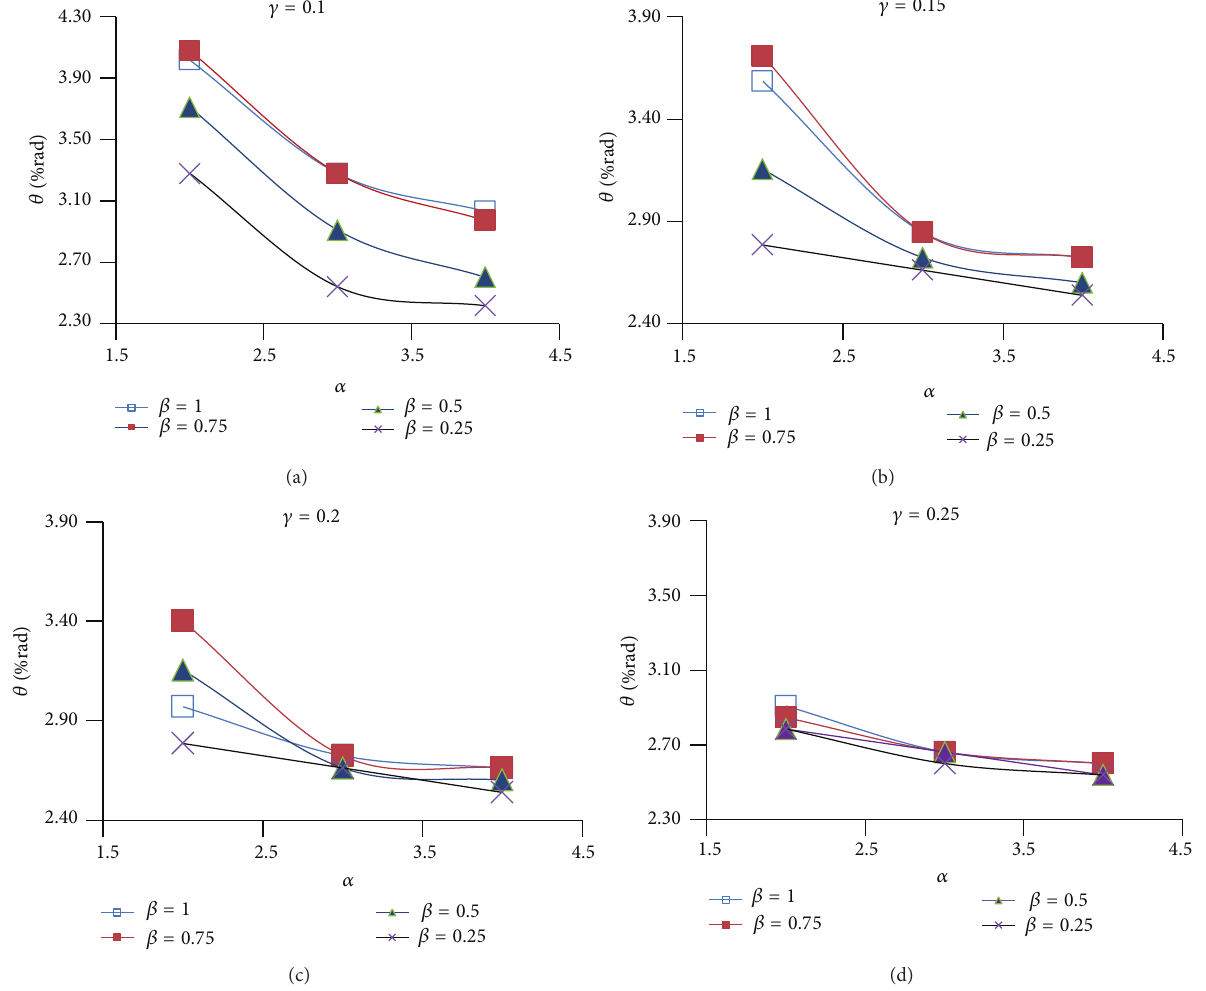
Figure 11: 𝜃 versus 𝛼 for different values of 𝛽 and 𝛾 for